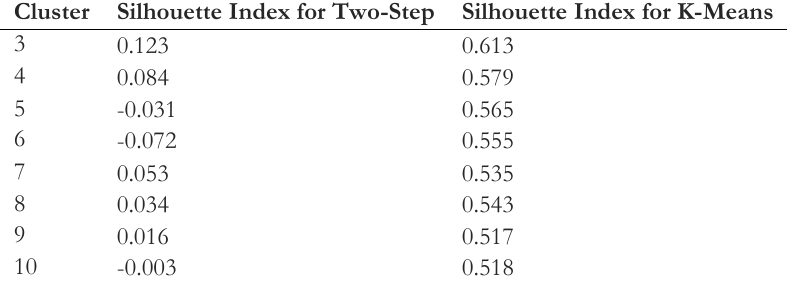
Table 6. Silhouette index values for K-means and two-step algorithm.